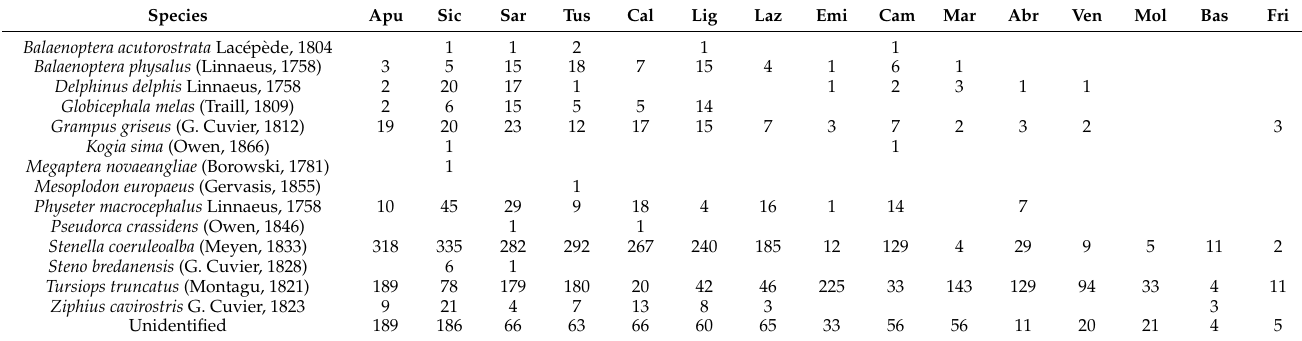
Figure 2. Number of stranding events (S.), the number of individuals stranded (I.S.), and the number of species stranded (S. s.) for each Italian region (see text for details and Supplement Figure S1 for map of the regions). The extent of strandings appears proportionate to the length of the coastline per region (see Figure S1 in Supplementary material). Table 1 shows the number of specimens stranded, corresponding to the individuals stranded (I.S.) values of Figure 2, per species (1990–2019) in the different Italian regions. Table 1. Number of specimens stranded, including entangled specimens (i.e., the I.S. in Figure 2) for each species (1990–2019) in the different Italian regions (Apu = Apulia; Sic = Sicily; Sar = Sardinia; Tus =Tuscany; Cal = Calabria; Lig = Liguria; Laz = Lazio; Emi = Emilia Romagna; Cam = Campania; Mar = Marche; Abr = Abruzzo; Ven = Veneto; Mol = Molise; Bas = Basilicata; Fri = Friuli Venezia Giulia) (see Supplemental Figure S1 for a map of the regions).